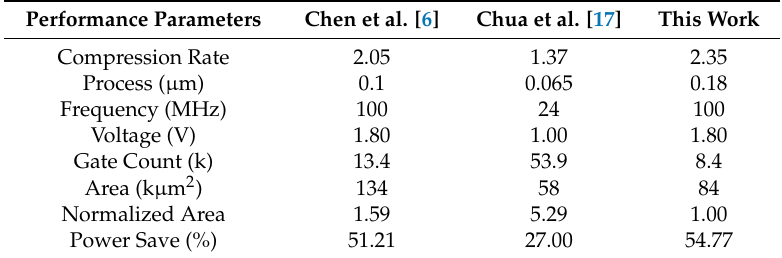
Table 3. Performance comparison of the proposed lossless EEG encoding algorithm and its VLSI architecture with a previous work.